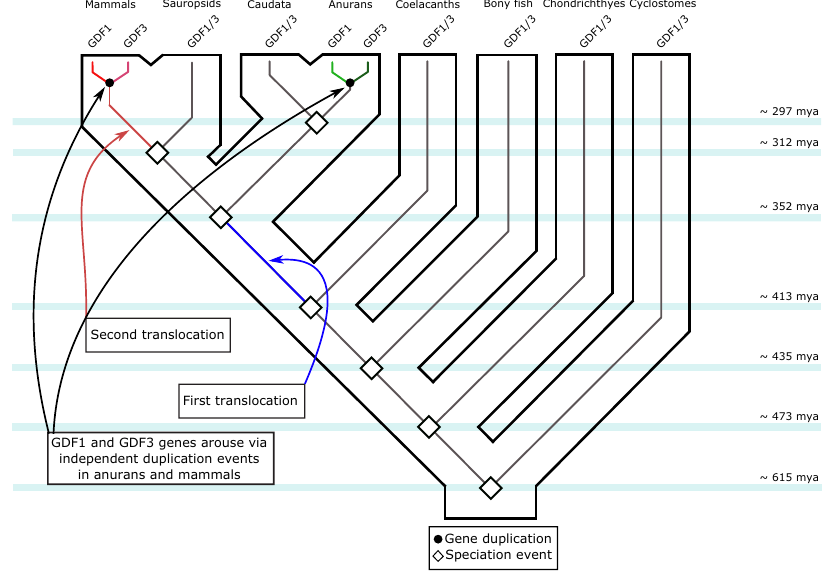
Figure 4. An evolutionary hypothesis of the evolution of the GDF1 and GDF3 genes in vertebrates. According to this model the last common ancestor of vertebrates had a repertoire of one gene (GDF1/3), a condition that has been maintained in actual species of cylostomes, chondrichthyes, bony fish, coelacanths, caudata and sauropsids. In the ancestor of tetrapods, the single gene copy was translocated to a different chromosomal location. After that, in the anuran ancestor, the single gene copy underwent a duplication event giving rise to the anuran GDF1 (Vg1) and GDF3 (derrière) genes. In the ancestor of mammals, the single gene copy also underwent a duplication event, giving rise to the mammalian GDF1 and GDF3 genes. After the duplication, but before the radiation of the group, a second translocation event occurred in the ancestor of the group. Thus, all mammals inherited a repertoire of two genes (GDF1 and GDF3) that were located on two